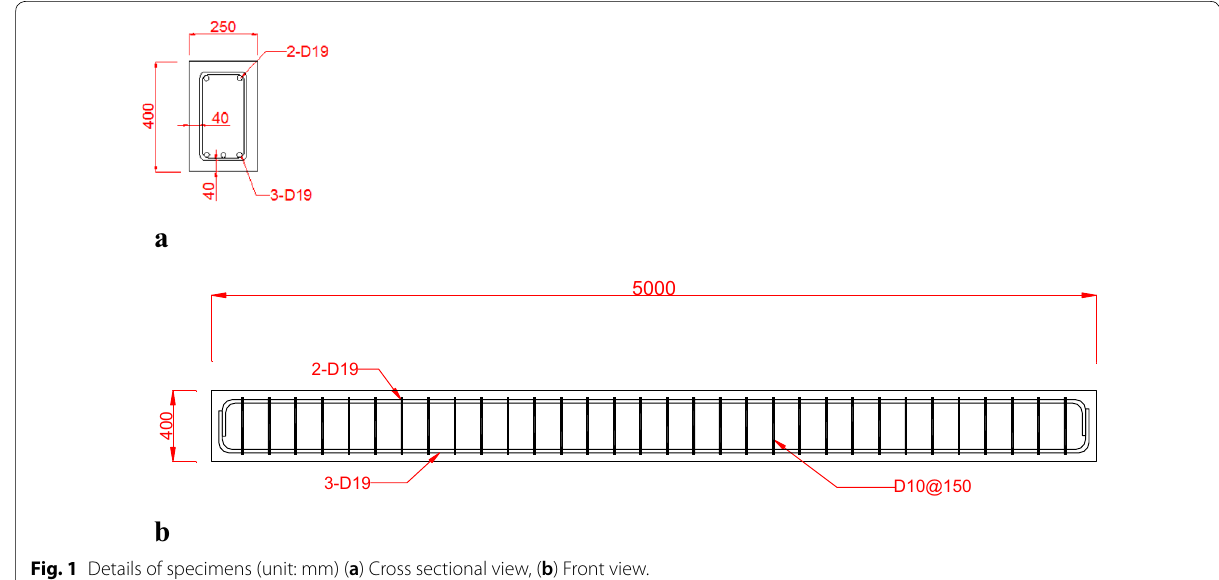
Fig. 1 Details of specimens (unit: mm) ( a ) Cross sectional view, ( b ) Front view.